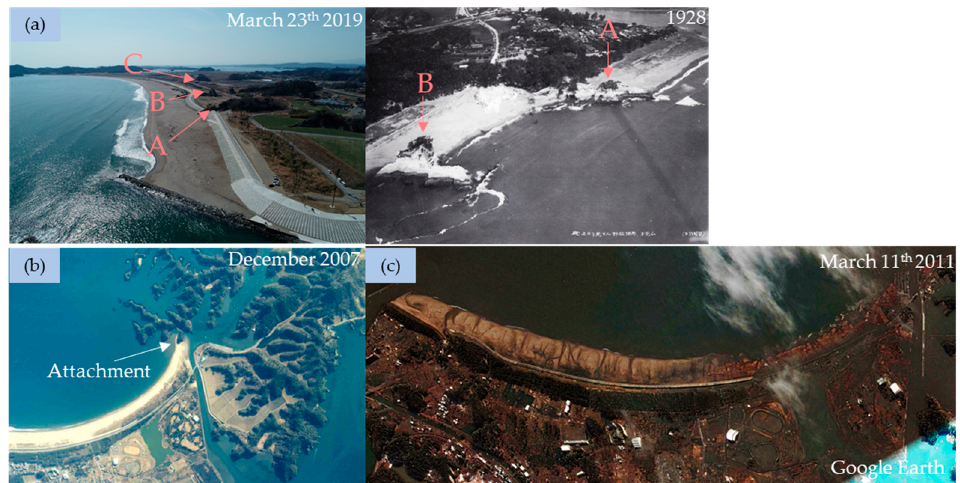
Figure 8. ( a ) Landlocked islands: left (UAV, Unmanned aerial vehicle), right [44]. ( b ) Severe deposition connecting to the Miyato Island (taken by Miyagi Prefectural Government). ( c ) Destruction of the Nobiru coast immediately after the tsu- nami.